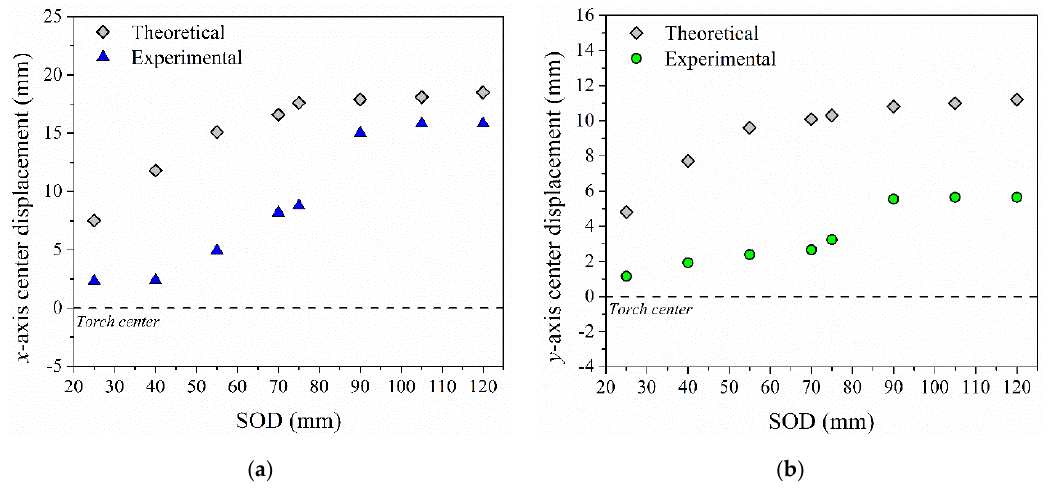
Figure 5. ( a ) x - and ( b ) y -axis displacement of static footprint respect to plasma stream (experimental and theoretical).